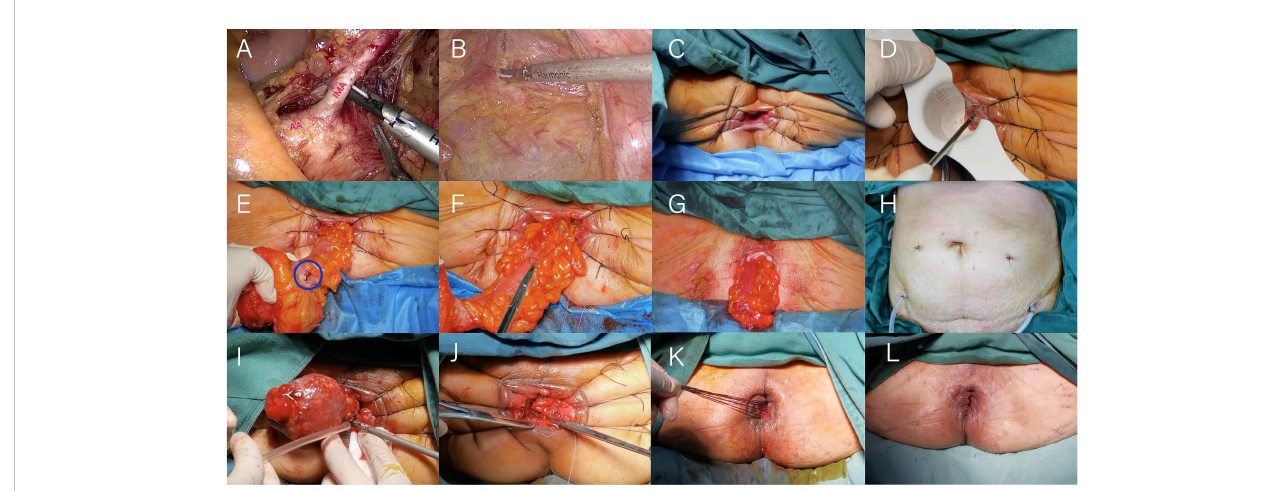
FIGURE 1 Illustration of the operation of laparoscopic modi fi ed Bacon surgery. (A) Lymph nodes around the inferior mesenteric artery are cleared. (B) The distal end of the rectum is dissociated to the level of the interspace between internal and external sphincters of anal canal. (C) Exposure of the surgical fi eld. (D) Incision of the whole rectum. (E) Pull out the bowel tube and check the blood supply. (F) The inner anal colon and the levator ani muscle were fi xed together. (G) Perineal appearance after resection of tumor bowel. (H) Two pelvic drainage tubes were placed. (I) Excision of excess colon. (J) The sigmoid colon was anastomosed to the rectal stump. (K) Unnecessary sutures are cut. (L) Perineal appearance after the second